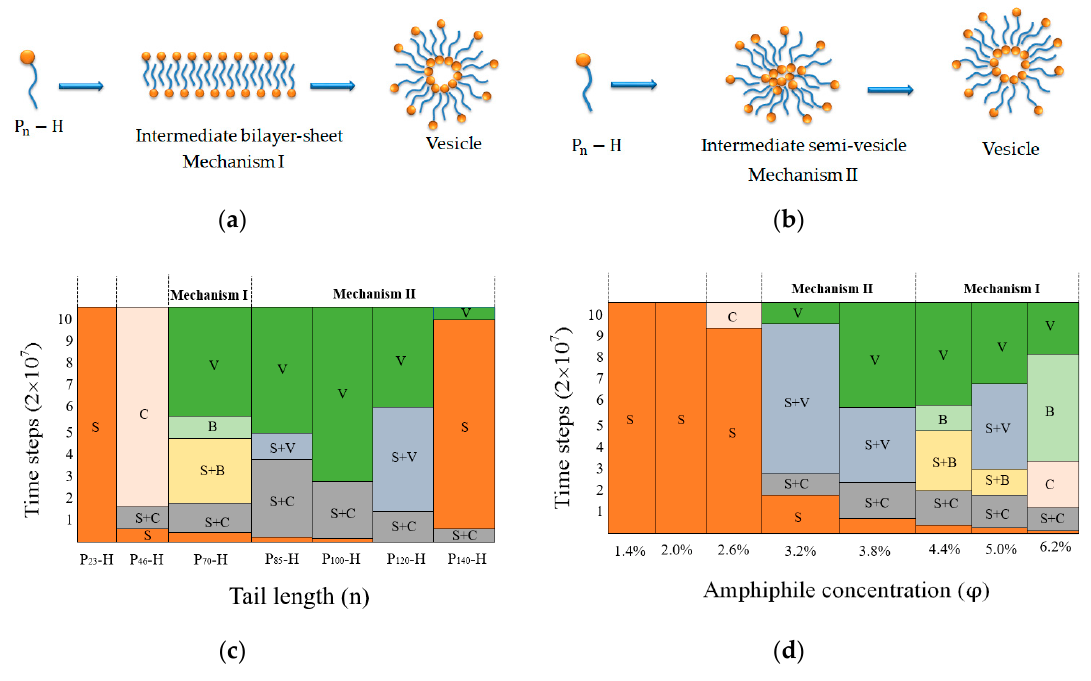
Figure 4. ( a , b ) Schematic drawings of Mechanisms I and II of the vesicle formation from P n –H amphiphiles, respectively. Dominant morphologies obtained at different time steps: ( c ) from different P n –H amphiphiles with 𝜑 = 4.4% and 𝑇 ∗ = 1.4 ; and ( d ) from different 𝜑 for P 70 –H